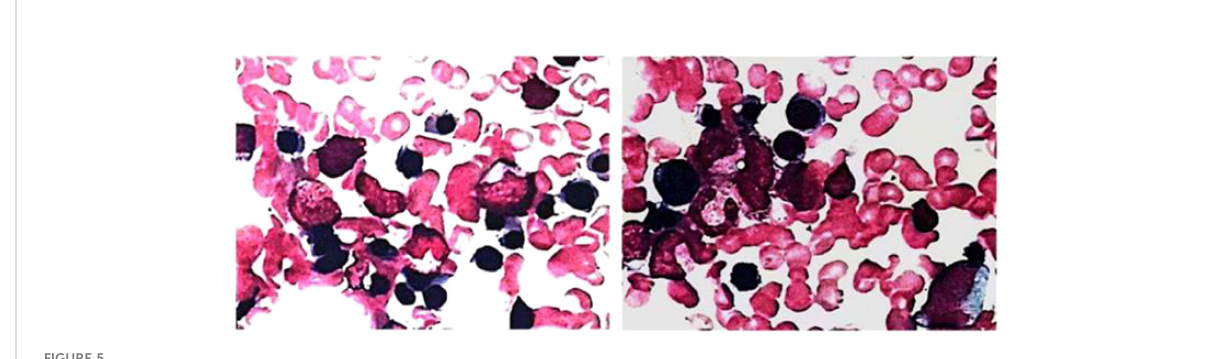
FIGURE 5 Bone marrow evaluation showed poor maturation of